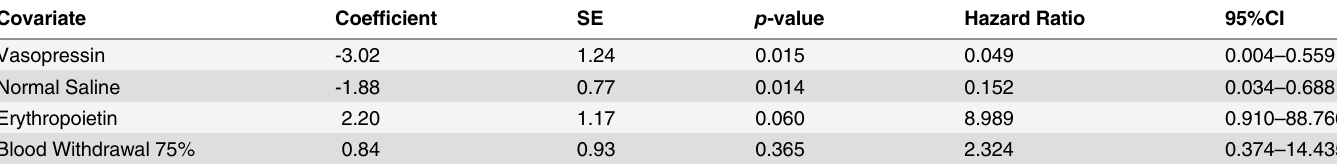
Table 3. Hazard ratios for main